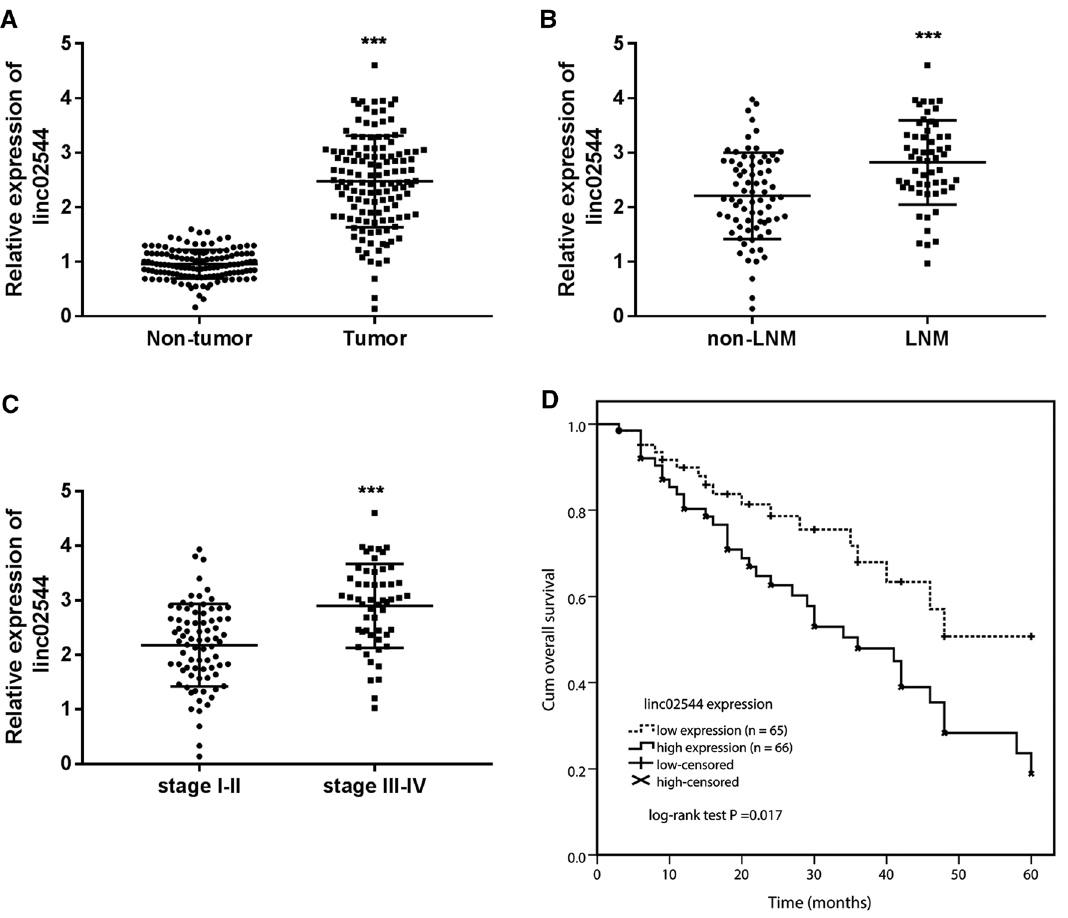
Fig. 1 Linc02544 was increased in LUSC tissue samples and predicted poor outcomes. A The linc02544 levels in LUSC tissue samples were higher than in adjacent non-tumor tissue samples. B linc02544 relative expression in tumor tissues of patients without LNM and patients with LNM. C linc02544 expression levels were higher in the tissues of patients at TNM stage III-IV than that in patients at stage I-II. *** P < 0.001. D Kaplan-Meier curve of linc02544 in LUSC. Log-rank test P =